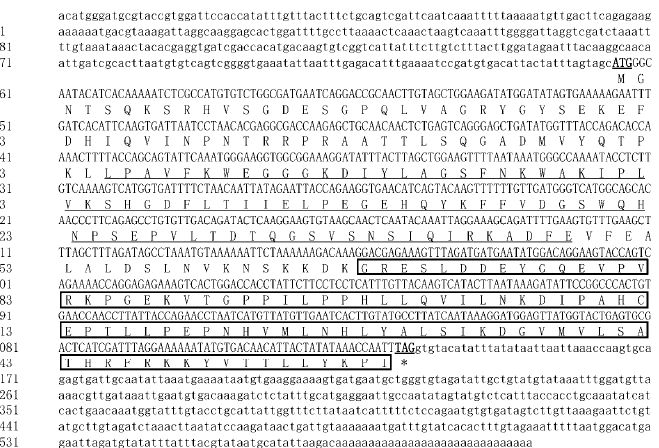
Figure 2. The nucleotide and predicted protein sequences of McAMPK β . The underlined areas rep- resent the CBM domain, and the black-framed regions represent the interaction domain, AMPKBI.